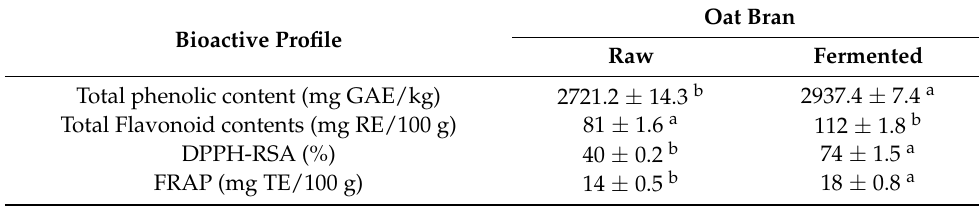
Table 2. Bioactive profile of raw and fermented oat